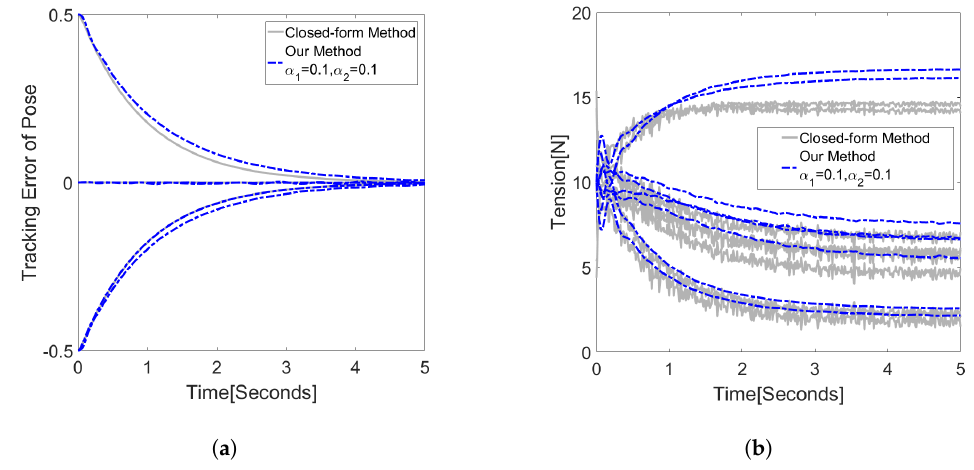
Figure 7. Comparison of our method and closed-form method (noisy case). Parameters and desired pose are selected as α 1 = 0.1, α 2 = 0.1, K d = 2, D d = 1, K i = 0, q d = [ 0.6, − 0.6,0.6,0,0,0 ] T . ( a ) Tracking error of pose. ( b ) Tension